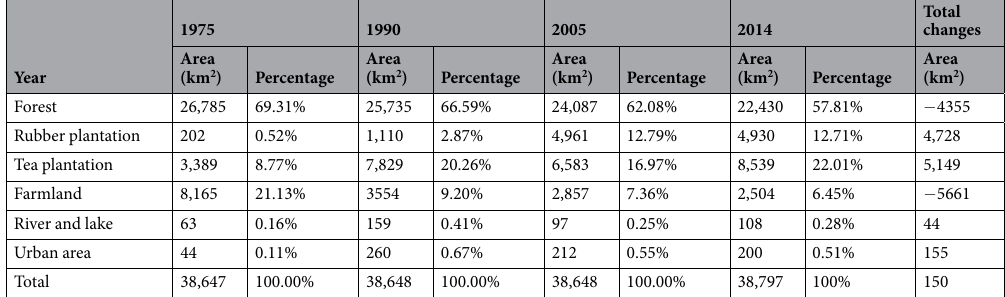
Table 1. Land cover types in Asia elephant range in China in 1975, 1990, 2005 and 2014 (km 2